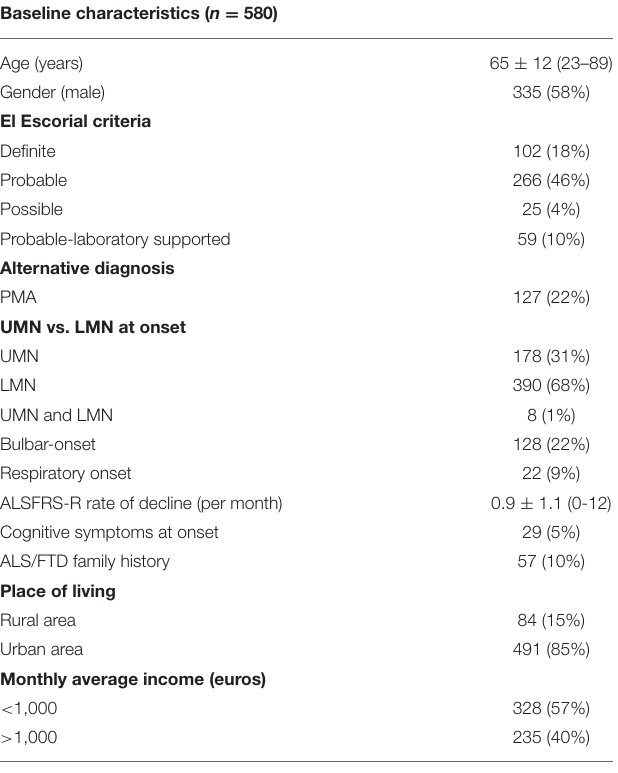
TABLE 1 | Baseline characteristics of ALS